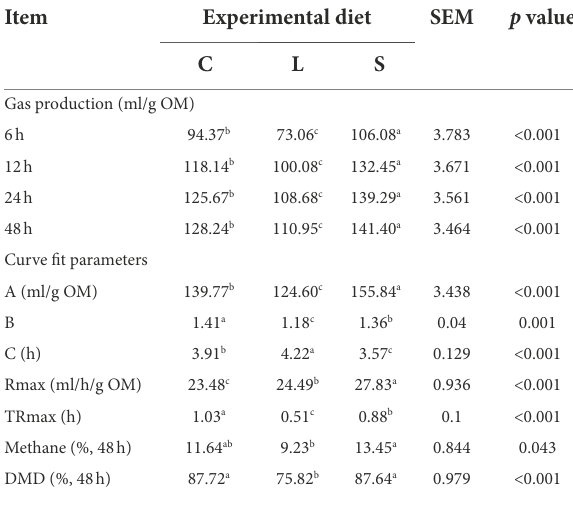
TABLE 2 Comparison of cumulative gas production at 6, 12, 24, and 48 h, curve fit parameters, head space methane concentration, and dry matter digestibility at 48 h among two glucogenic (C, S) and a lipogenic (L) diet under in vitro fermentation with rumen fluid of dairy